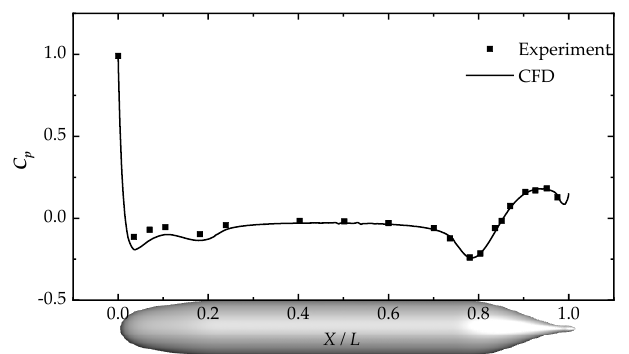
Figure 5. Validation of the pressure coefficient along the upper meridian.